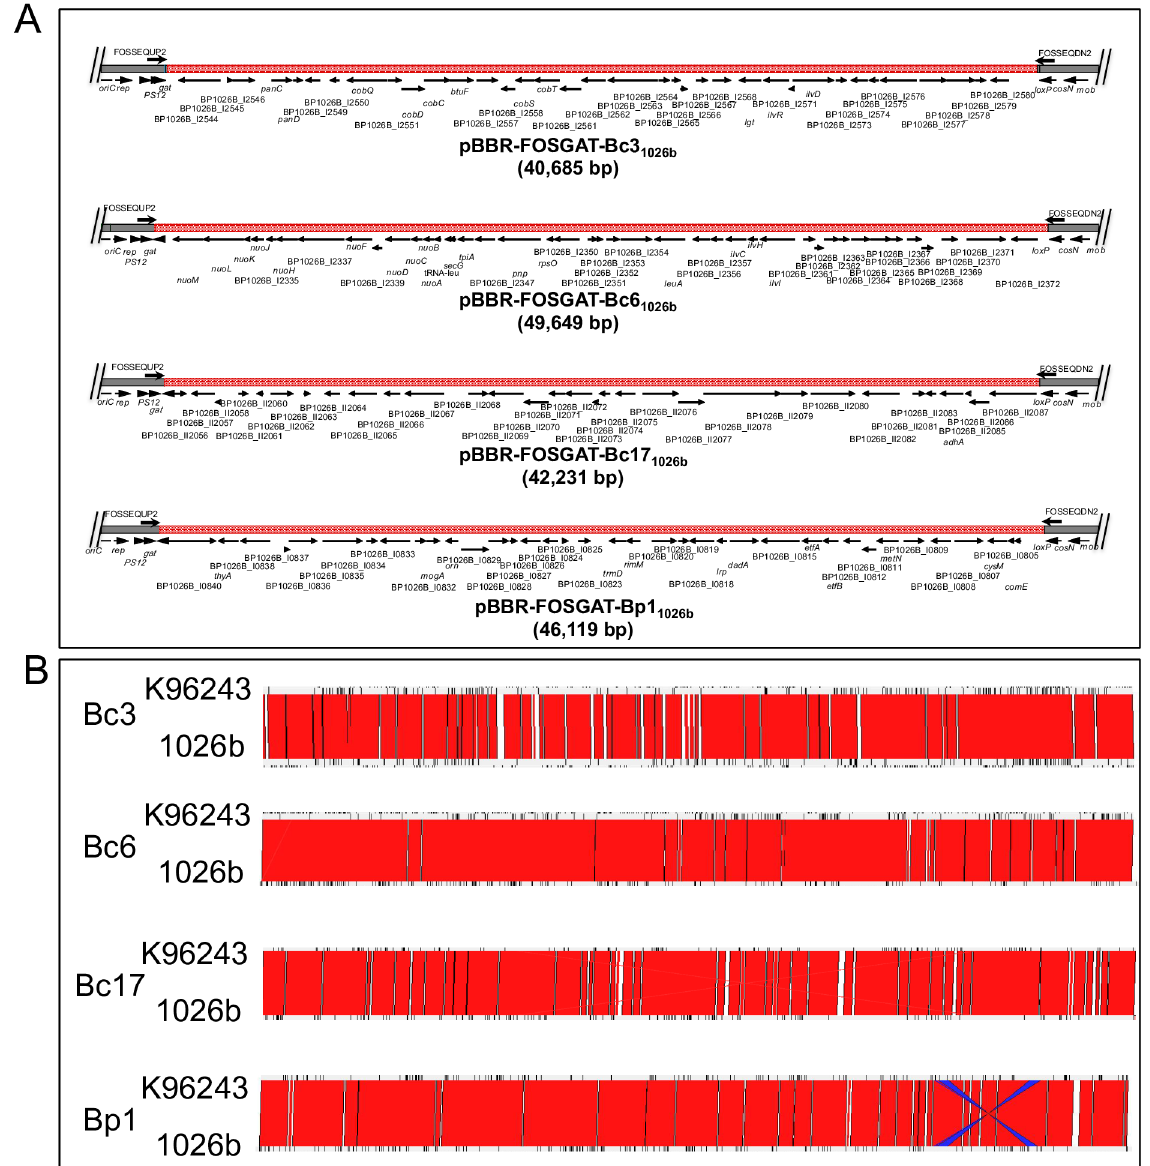
Fig 3. Gene content of four fosmid clones conferring natural competency and/or DNA catabolism. (A) The fosmid backbone is indicatedin black and the red regiondepicts the extent of Bp 1026b genomicDNA inserted in each fosmid. Gene products with known predicted functions are indicatedby gene names and those with unknownfunctions are labeledwith gene identifications. (B) Synteny map comparingfosmid regionsof Bp K96243and 1026b. Red regions indicatethe high level of similarity betweenfosmid regions in strain K96243(non-competent) versus 1026b (competent) alignedusing Artemis webACT. Identical regionsare indicated in red, non-identical regions in white, and blue indicatesa regionthat is invertedin the two strains.